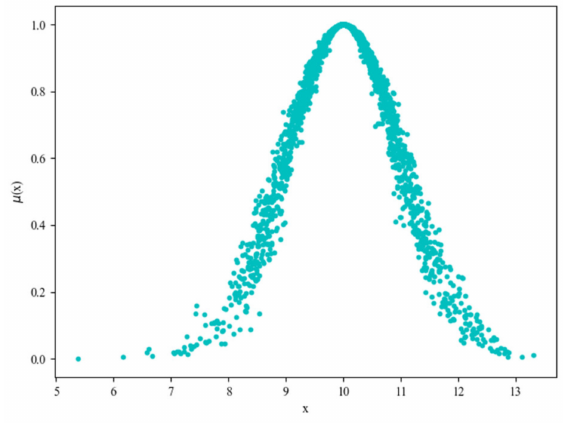
Figure 12. The normal cloud model.